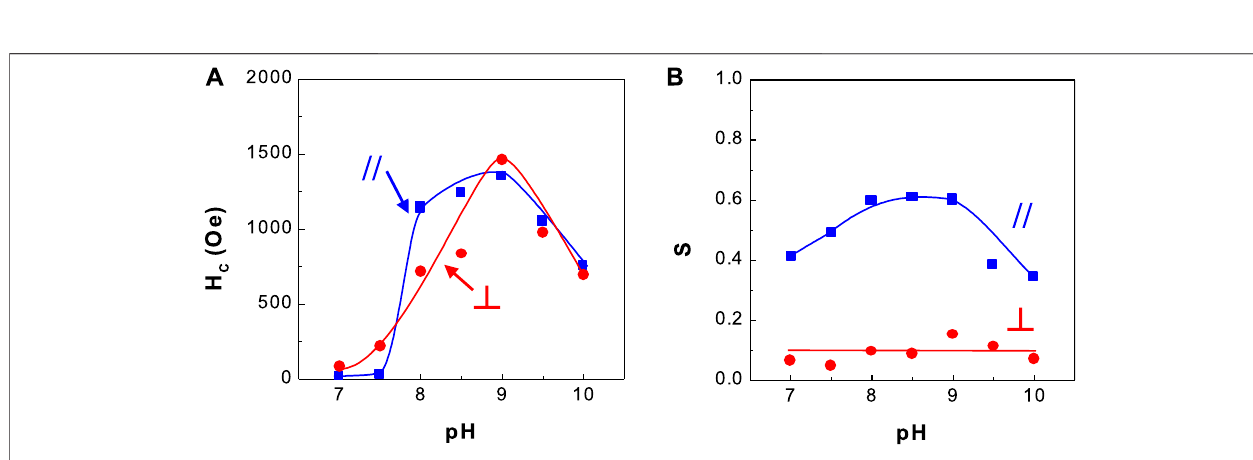
FIGURE 4 | Dependence of coercivity and squareness of CoPt thin fi lms on H 2 PtCl 6 concentration (A) coercivity and (B) squareness.